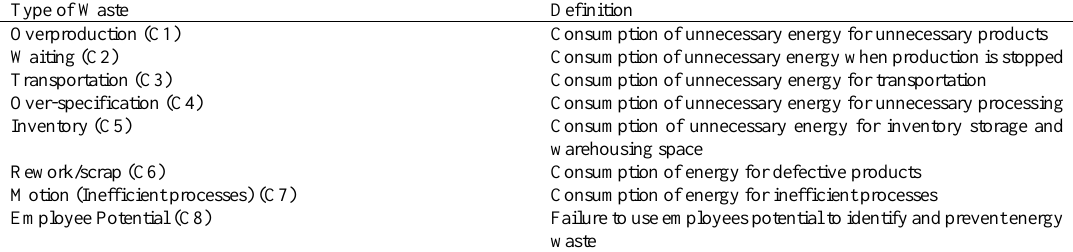
Table 1. Eight kinds of waste for energy (environmental protection agency (EPA), 2011) Type of Waste Definition Overproduction (C1) Consumption of unnecessary energy for unnecessary products Waiting (C2) Consumption of unnecessary energy when production is stopped Transportation